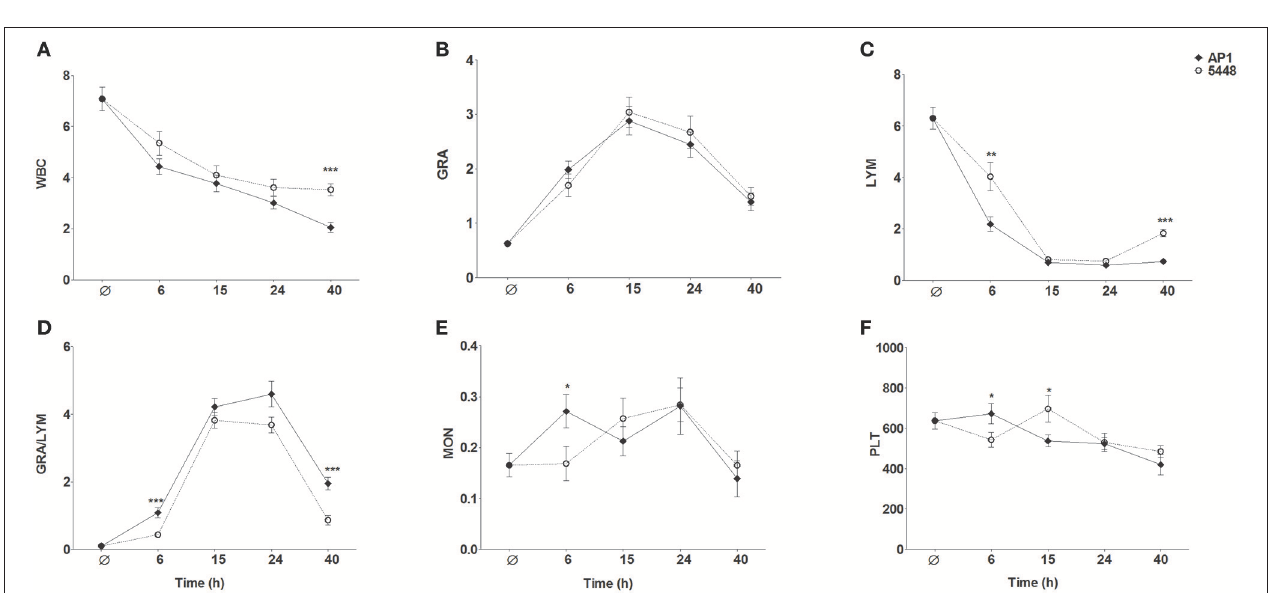
FIGURE 6 | Changes in peripheral blood indices throughout the 40h time course of infection. The same data were used as for the MDS shown in Figure 5 . The graphs represent mean ± SD of 13–15 mice per group; data were combined from five independent complete time course experiments featuring three mice per treatment. * P ≤ 0.05, ** P ≤ 0.01, *** P ≤ 0.001, Mann-Whitney U -test. The data represent absolute numbers of cells x10 9 / µ l except GRA/LYM ratio, which represents the absolute granulocyte count divided by the absolute lymphocyte (A) WBC, white blood cell, i.e., leukocyte, counts; (B) GRA, granulocytes; (C) LYM, lymphocytes; (D) GRA/LYM, granulocyte/lymphocyte ratio; (E) MON, monocytes; (F) PLT, platelets (thrombocytes).